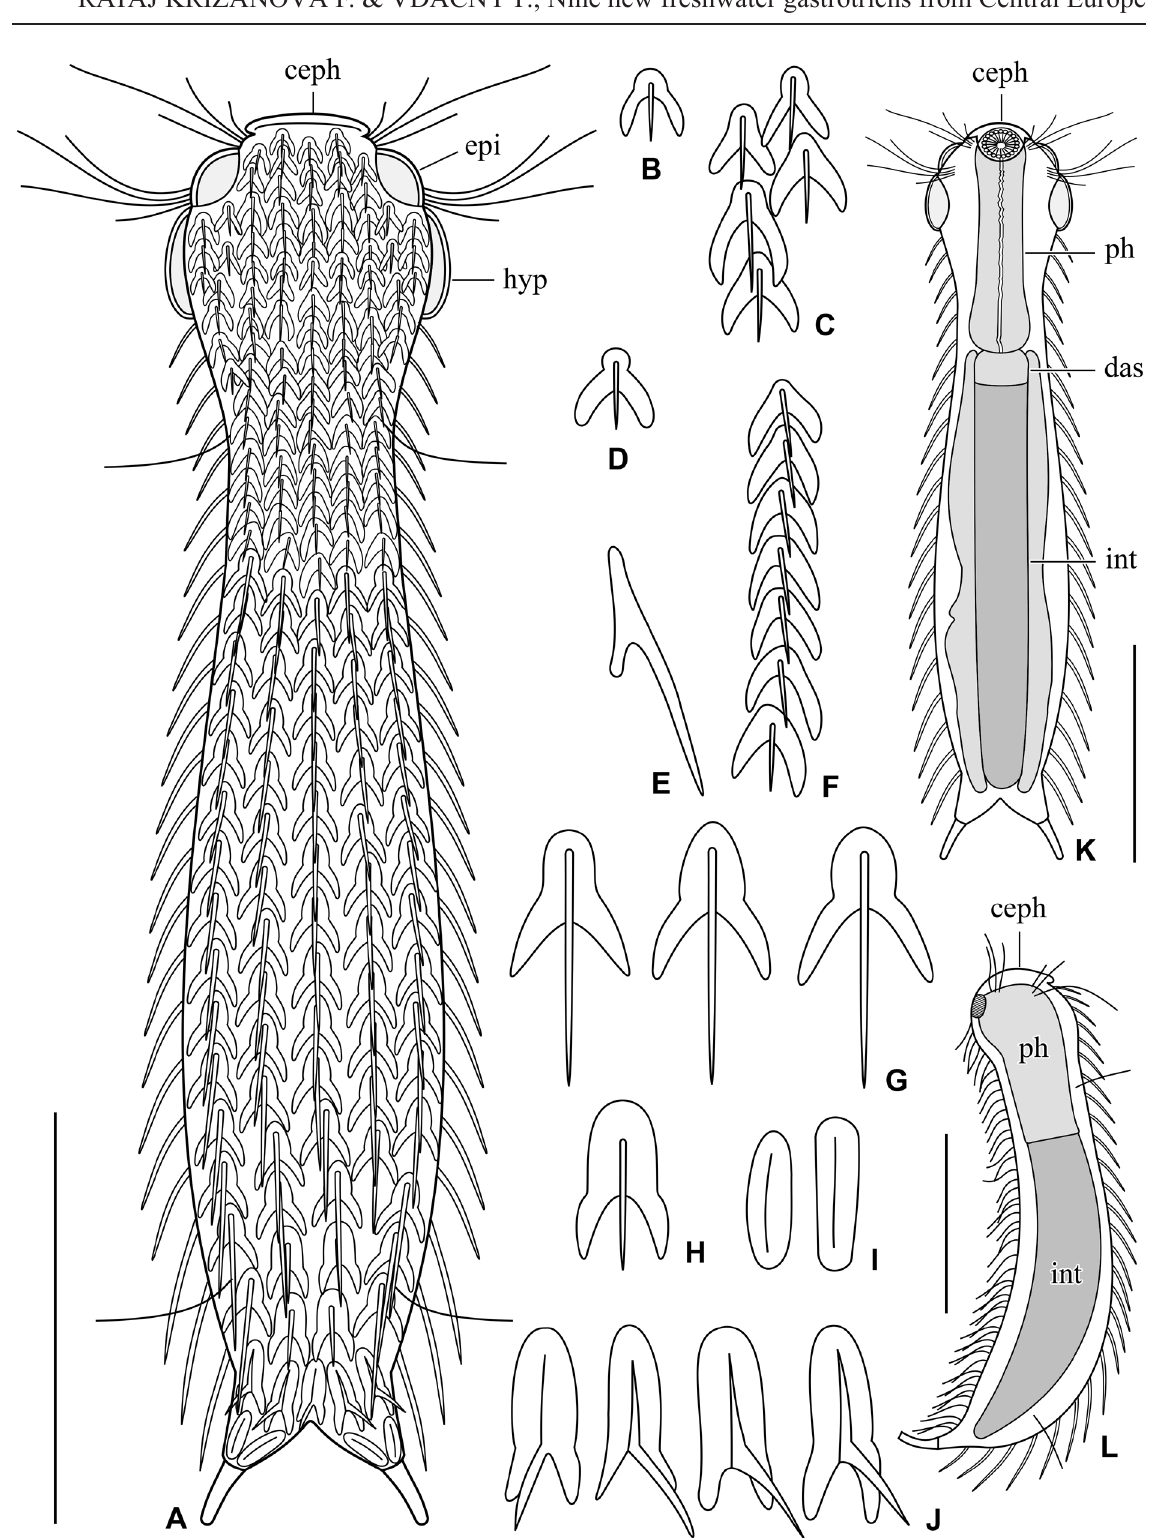
Fig. 23. Chaetonotus ( Hystricochaetonotus ) avarus sp. nov. A . Dorsal overview showing the scale and spine pattern. B – C . Head scales. D . Neck dorsolateral scale. E . Lateral view of a trunk spined scale. F . Neck central scales. G . Trunk scales. H . Posterior trunk scales. I . Dorsal furca branches scales. J . Dorsal furca base scales. K . Internal morphology. L . Lateral overview. Scale bars = 30